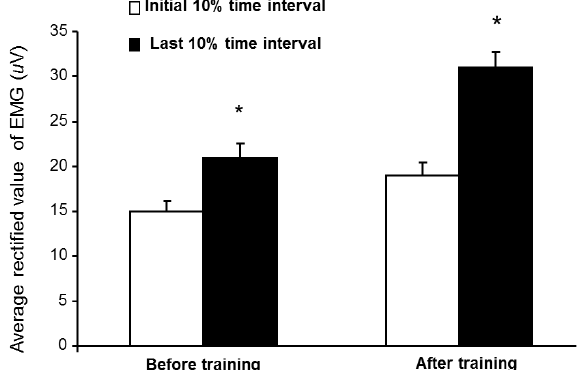
Average rectified value of EMG obtained from the initial and last 10% interval of the time to task failure of the trained leg (average for the VM, RF and VL muscles) during sustained isometric knee ex- tension at 50% of MVC measured before and after 12 weeks resistance training. * p ≤ .05.